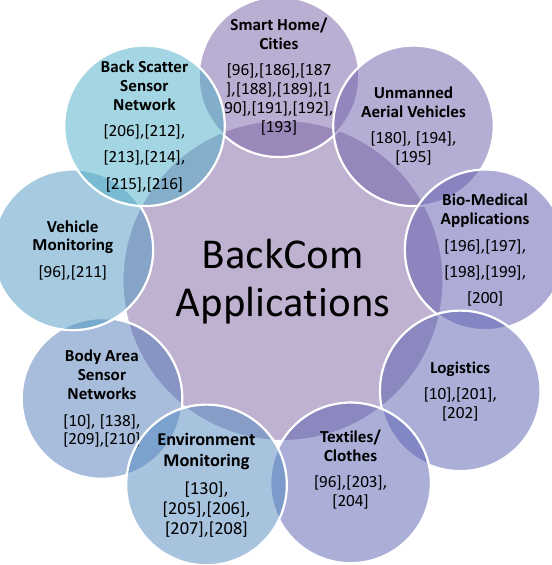
Figure 40. Applications of BackCom.